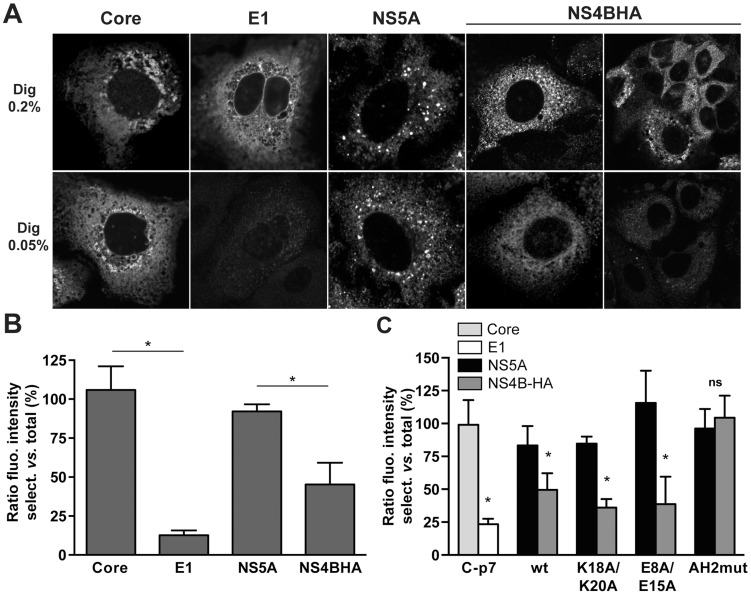
The N-terminal part of NS4B assumes a dual topology in a replicative context.(A) Huh7-Lunet cells harboring a subgenomic HCV JFH1 replicon with an HA tag inserted between NS4B AH1 and AH2 (see Materials and Methods section) were subjected to total (0.2% digitonin [Dig 0.2%], upper row) or selective membrane permeabilization (0.05% digitonin [Dig 0.05%], lower row), as described in the Materials and Methods section. As a control, replicon cells were transfected with a CMV promotor-driven core-E1-E2-p7 expression construct. Core and NS5A served as controls for cytosolically oriented proteins, E1 as a control for a luminally oriented protein. Monoclonal antibodies C7-50 against HCV core, A4 against E1, 9E10 against NS5A, and HA-7 against the HA tag were used, followed by anti-mouse IgG Alexa Fluor 488 as secondary antibody. Images were acquired on a confocal laser scanning microscope with the same settings for each antibody and condition. Analogous results were obtained when polyclonal antibody Y-11 against the HA tag was used instead of monoclonal antibody HA-7. (B) Histogram of the fluorescence intensity ratios between selective and total membrane permeabilization conditions. Fluorescence intensities in 10–60 images for each condition were determined by using ImageJ software [70]. (C) H7-T7-IZ cells were transfected with a CMV promotor-driven core-E1-E2-p7 expression construct or T7 RNA polymerase-driven N3-5B polyprotein expression constructs harboring the different mutations in HA-tagged NS4B, followed by selective membrane permeabilization and immunofluorescence microscopy using the same antibodies as in panel A. Fluorescence intensity ratios between selective and total membrane permeabilization conditions were determined as in panel B. AH2mut is a previously described mutant harboring alanine substitution of 6 aromatic amino acid residues in NS4B AH2 [15]. This mutant is unable to translocate AH2 through the membrane bilayer. * P≤0.0001; ns, non significant (P>0.25).